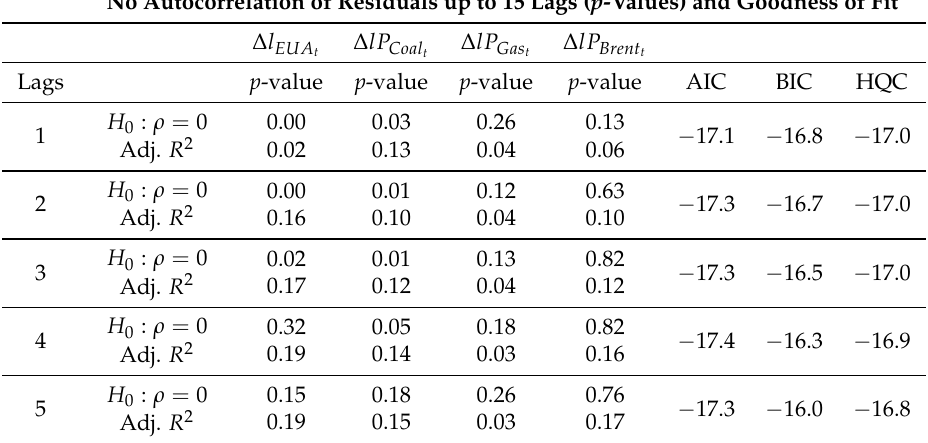
Table 6. Misspecification tests and goodness of fit for VECM with weekly forward prices. No Autocorrelation of Residuals up to 15 Lags ( p -Values) and Goodness of